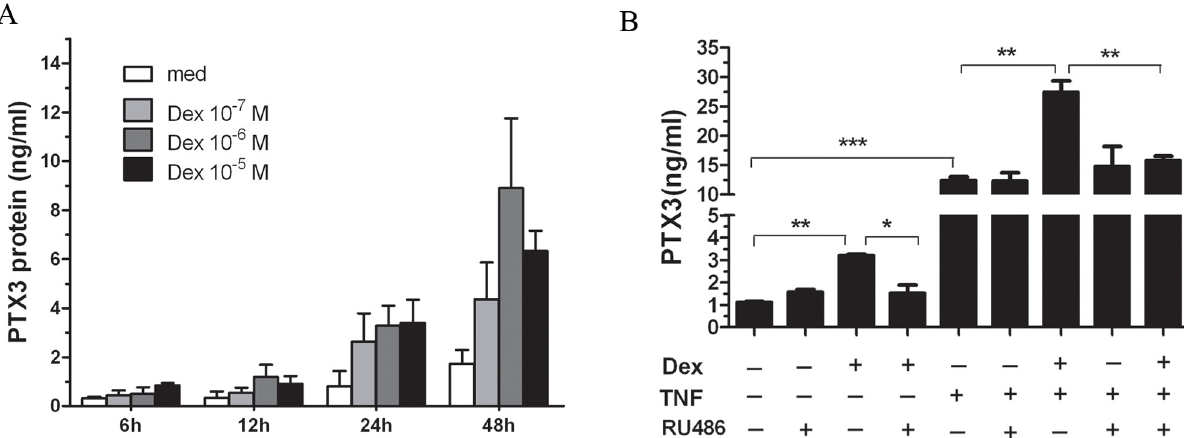
Fig 1. Effect of dexamethasone (DEX) and TNF on PTX3 secretion in HASMC. (A) Supernatants from serum-deprived HASMC stimulated with various concentrations of DEX (10 − 7 M, 10 − 6 M, and 10 − 5 M) were harvested at different time point (6, 12, 24 and 48 h) and analyzed by ELISA for PTX3; (B) Grow-arrested HASMC were treated with DEX (10 − 6 M) and/or TNF (10ng/ml) for 24 h and RU486 (10 μ M) added 30 min before. PTX3 secretion was assessed by ELISA. Data are presented as the mean ± SD of five independent experiments in triplicate ( � p < 0.05, �� P < 0.01, ��� P < 0.001).